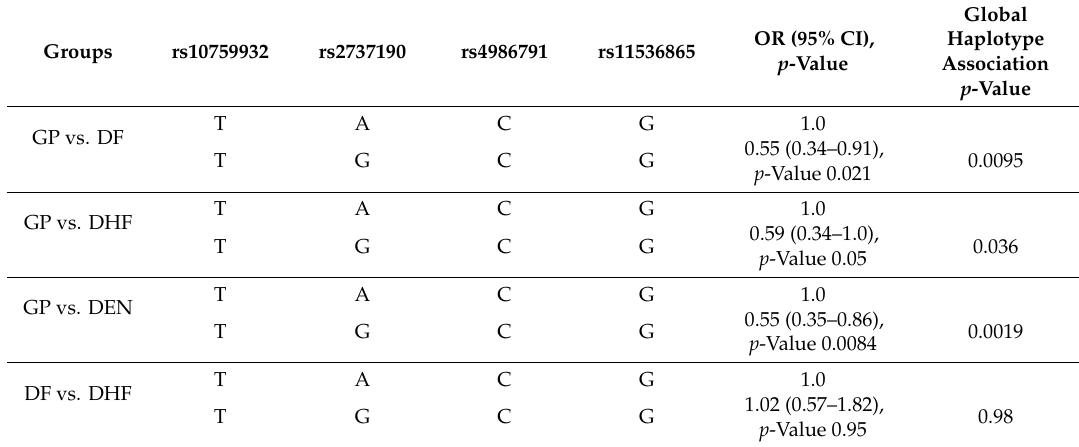
Table 8. Haplotype association of TLR4 with the clinical forms of dengue.